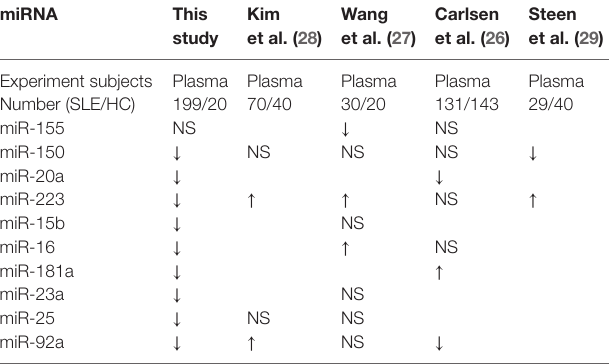
TaBle 8 | The comparison of circulating miRNAs in our study with other SLE studies.